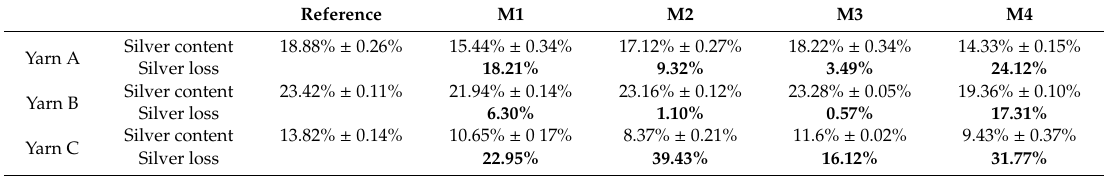
Figure 10. TGA curves of the reference Yarns A, B and C. Table 6. Comparison of the silver loss according to the washing conditions.